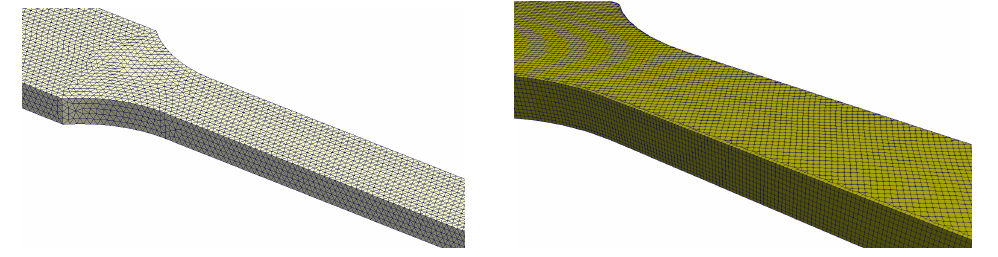
(cid:13) [11] (left) and openInjMoldSim (right).